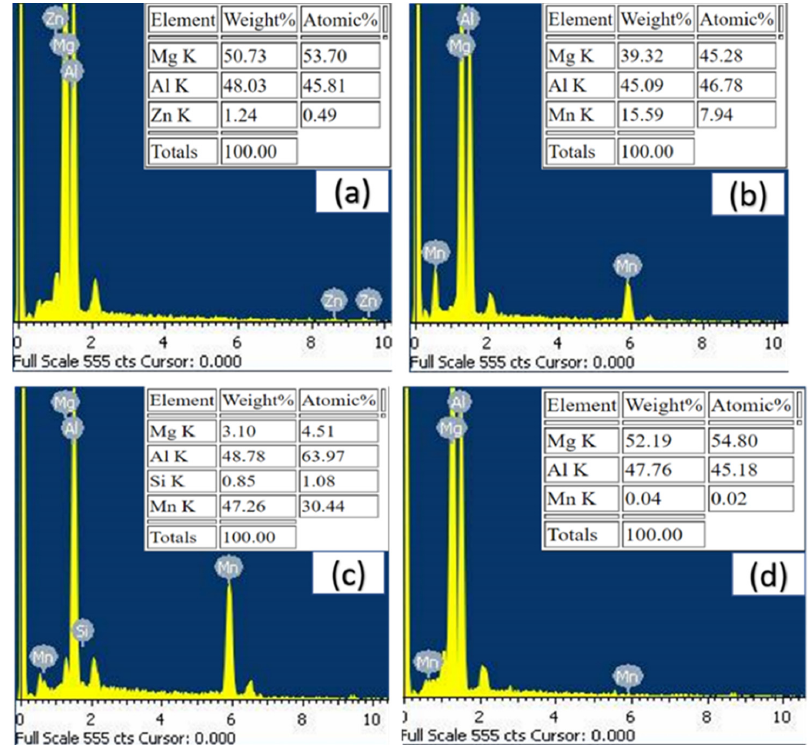
Figure 10. EDS spectra of ( a ) pure AZ9 matrix, ( b ) AZ91 + 0.5 wt.% SiCp and ( c , d ) AZ91 + 1 wt.% SiCp.